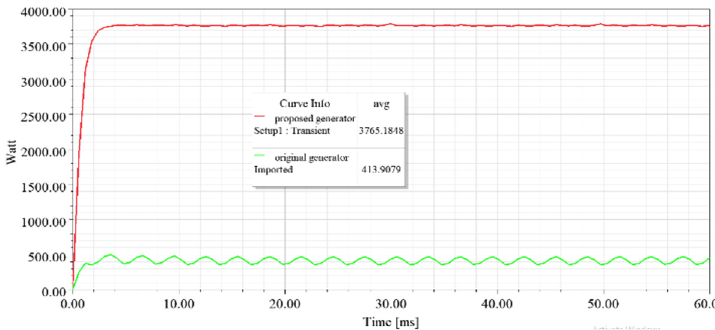
Figure 20. Output power of original generator and proposed generator.